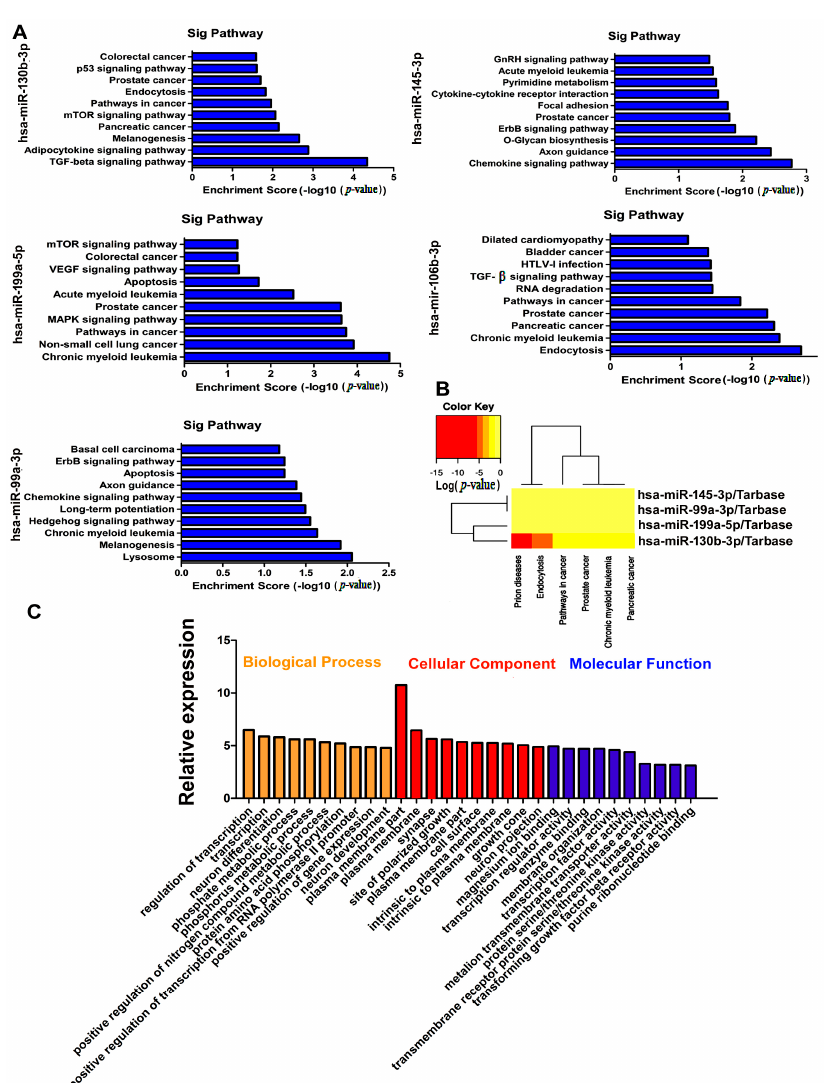
Figure 4. Pathways of target genes for the five representative miRNAs are analyzed. ( A ) KEGG pathway enrichment analysis with a top ten Enrichment score; ( B ) Hierarchical clustering of miRNA related pathways. The heatmap of the miRNAs merged pathway reveals significance by p -value (log scaled). Red represents high significance; and ( C ) DAVID analysis of target genes of miR-130b-3p.